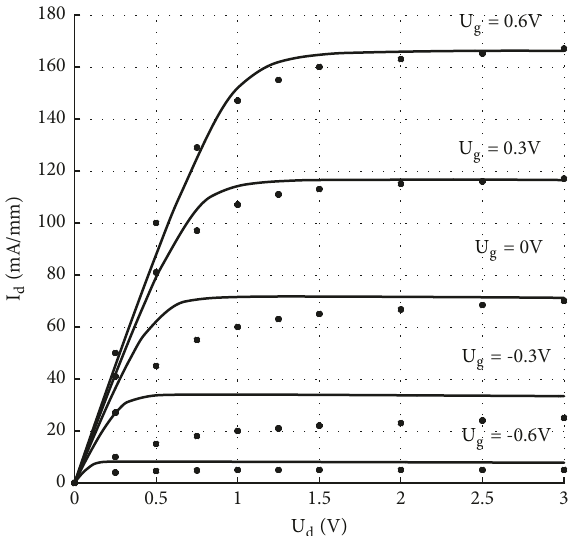
Figure 4: Experimental [21] (dotted lines with circle marks) and simulation (solid lines) current-voltage characteristics of HEMT transistor with 𝐿 𝑔 = 500